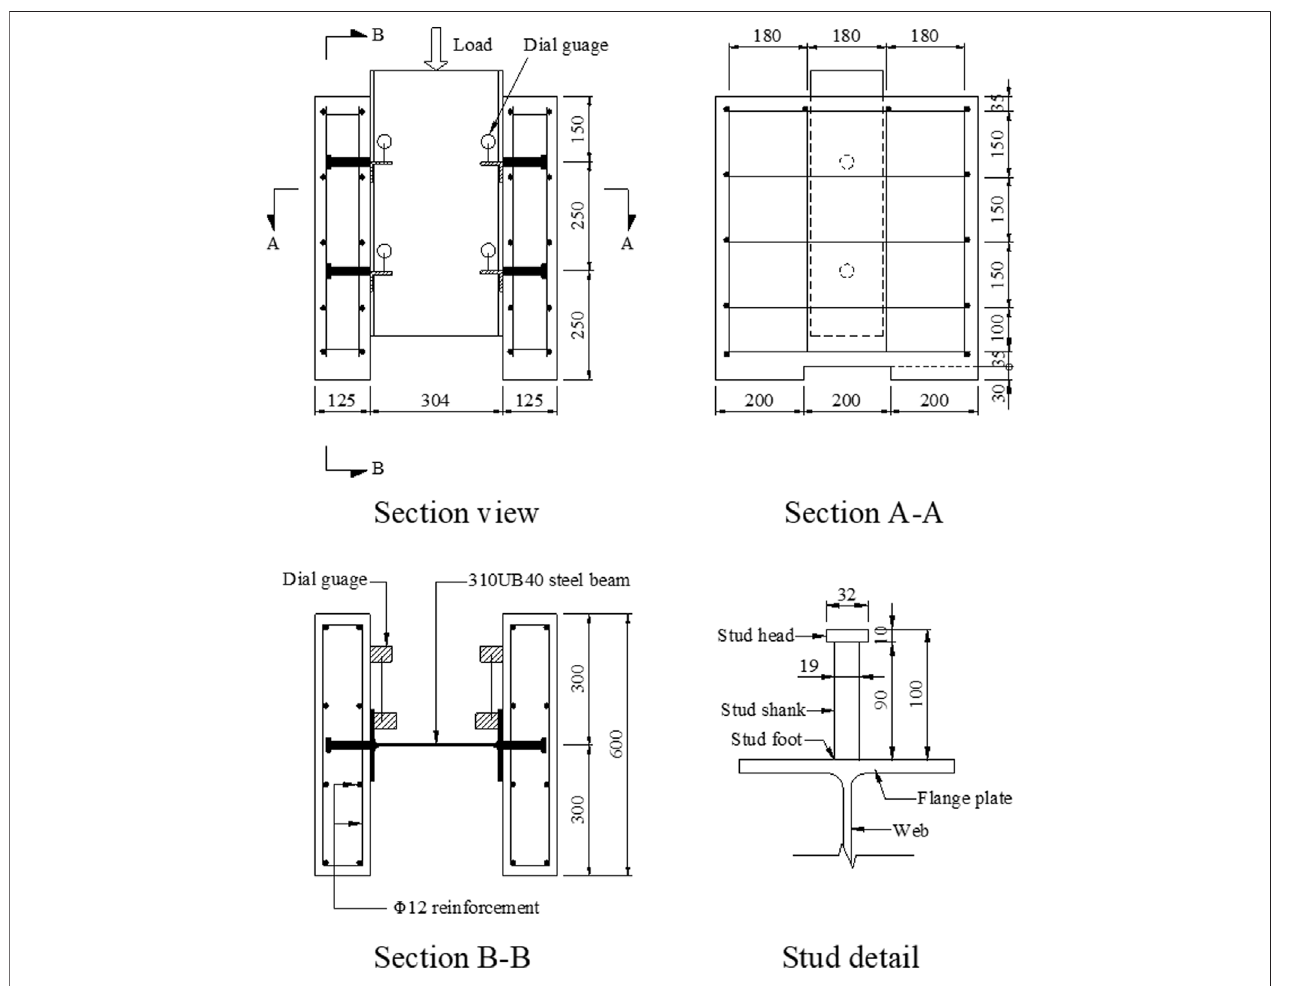
FIGURE 3 | Structural details of the push-out specimen (unit: